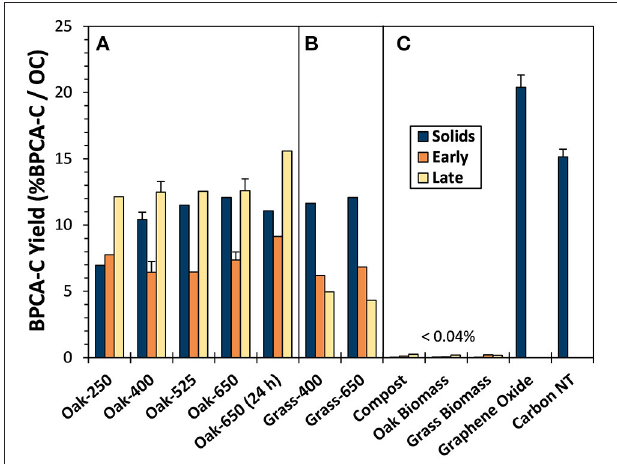
FIGURE 3 | BPCA-C yield from (A) oak char thermal series, (B) grass chars, and (C) reference material solids and leachates during days 1 and 2 (“Early”) and days 16 and 17